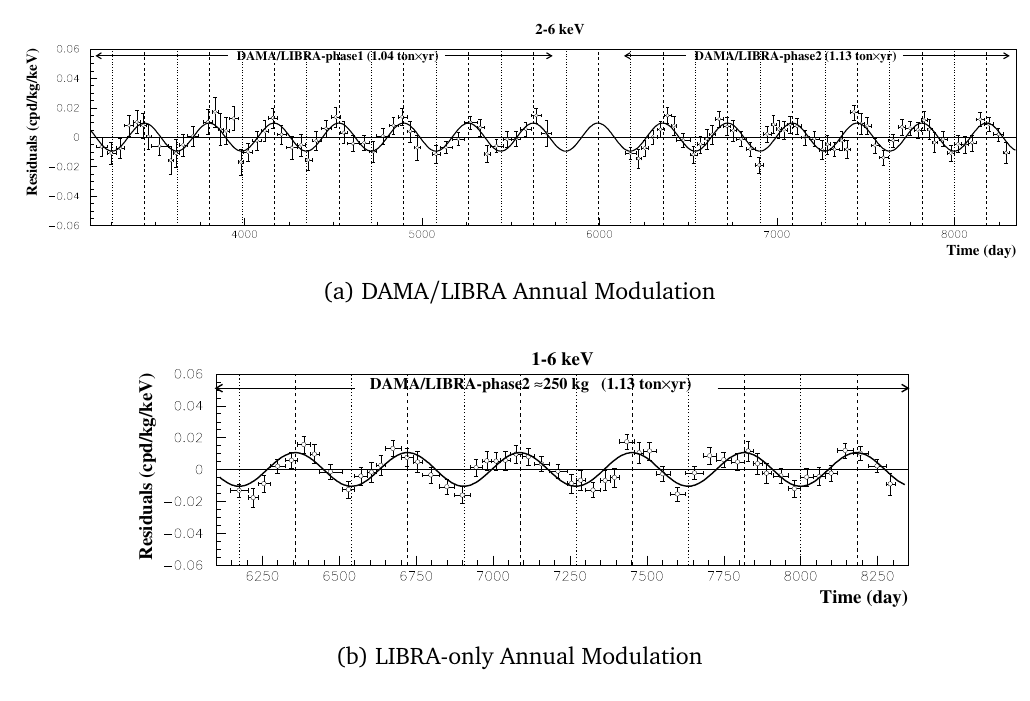
Figure 27: Results from the DAMA / LIBRA Experiment. (Top) The full 14-cycle DAMA / LIBRA annual modulation result, after subtracting flat background contribu- tions. This analysis uses a higher energy threshold in the range of 2 − 6 keV of recoil energy. (Bottom) The LIBRA-only results allowing for a lower-energy threshold of 1 − 6 keV in recoil energy. Figures extracted from [ 39 ]